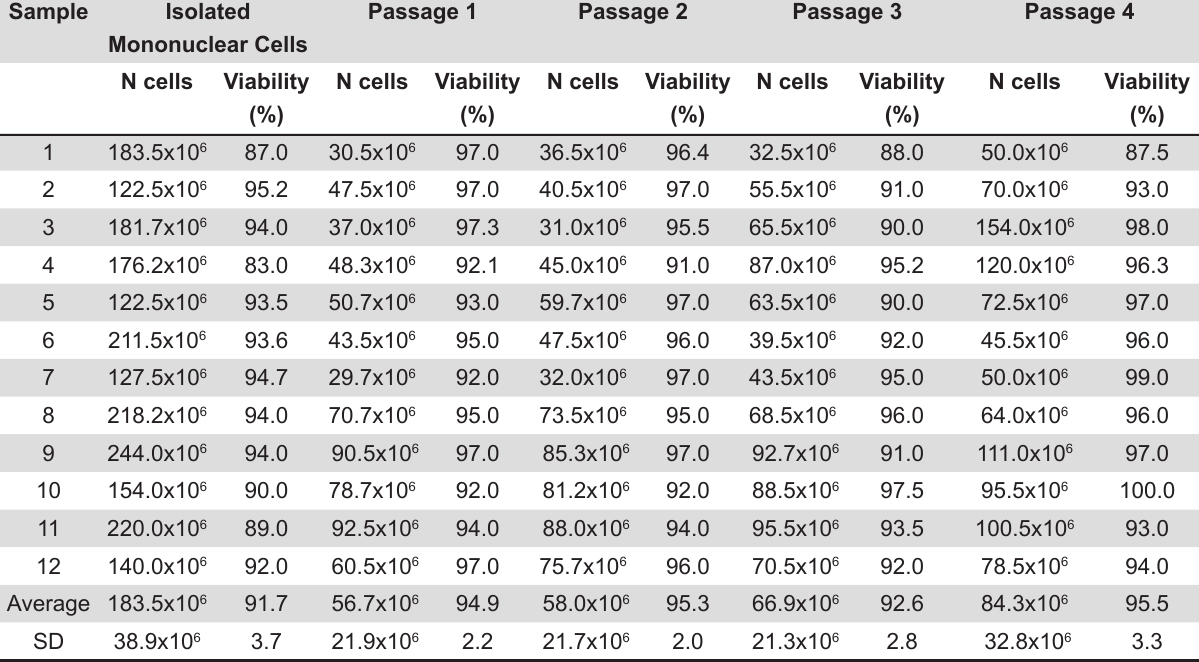
Table 1- Total number and viability of mononuclear cells isolated from bone marrow of minipig BR-1 and number and viability of mesenchymal stem cells in each